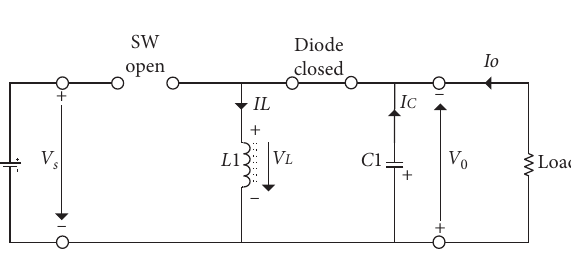
Figure 3: Buck-boost converter switch, open